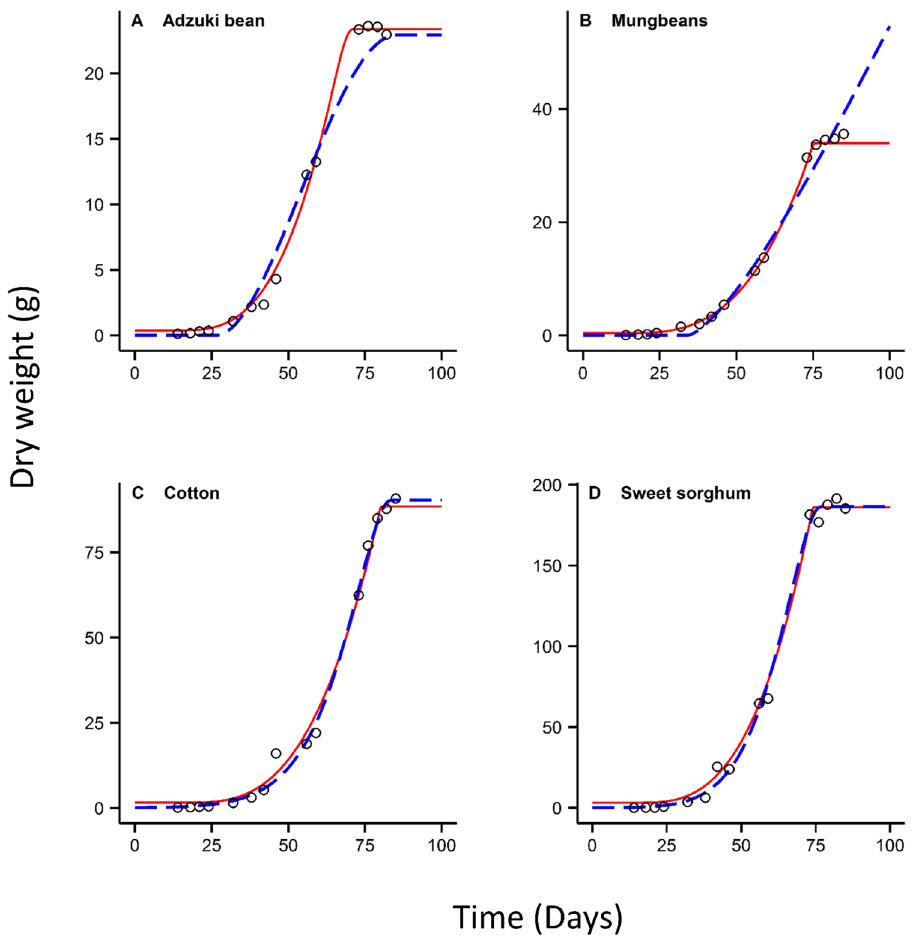
Figure 2. Comparison of fitted growth curves of the new growth model and the beta growth model in Eq. (4) for the growth datasets of adzuki bean, mung beans, cotton and sweet sorghum. Circles represent the actual biomass observed. Red lines and black dashed lines represent the fitted curves of the new sigmoidal growth model and the beta sigmoidal growth model, respectively.